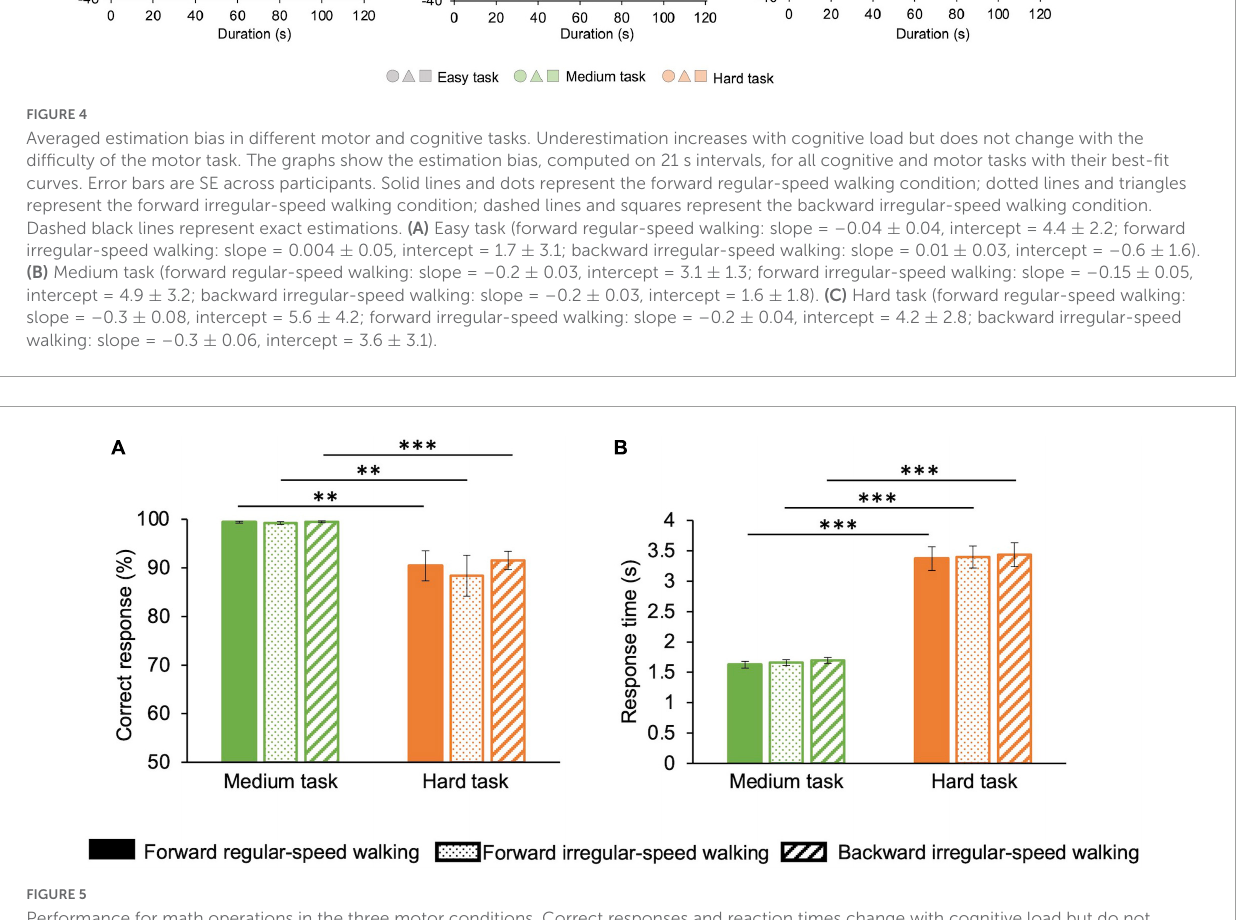
FIGURE5 Performance for math operations in the three motor conditions. Correct responses and reaction times change with cognitive load but do not change with the difficulty of the motor task. Green: medium task; orange: hard task. Solid bars correspond to the forward regular-speed walking; dotted bars correspond to the forward irregular-speed walking; striped bars correspond to the backward irregular-speed walking. (A) Percentage of correct responses. (B) Response times. Asterisks mark statistically significant differences with ANOVAs: ∗∗ p < 0.01, ∗∗∗ p < 0.001. Error bars are SE across